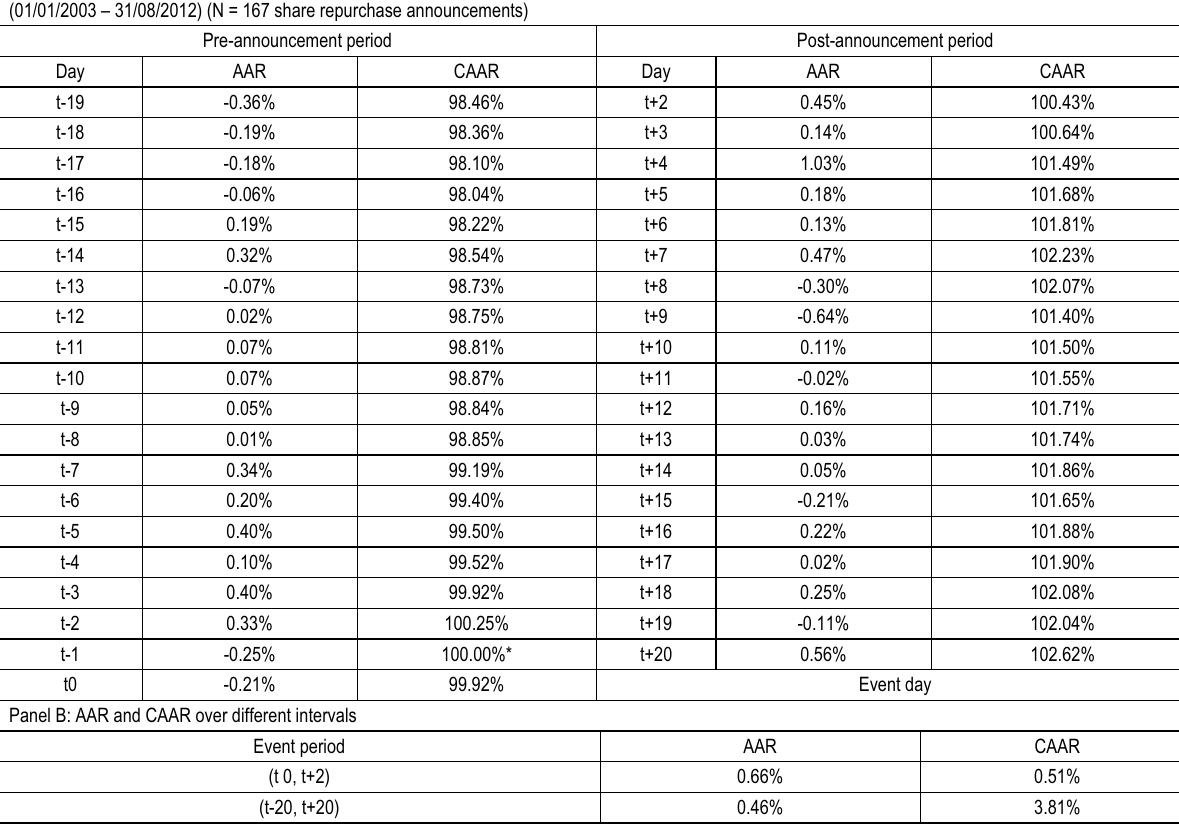
Table 5 (cont.). Daily AAR and CAAR for the final